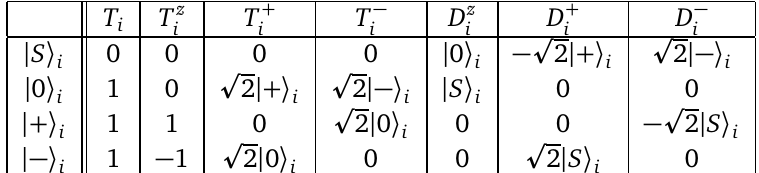
Table 1: Action of local total-spin and spin-difference operators (2) on the local spin-dimer basis states (6). Because quantum